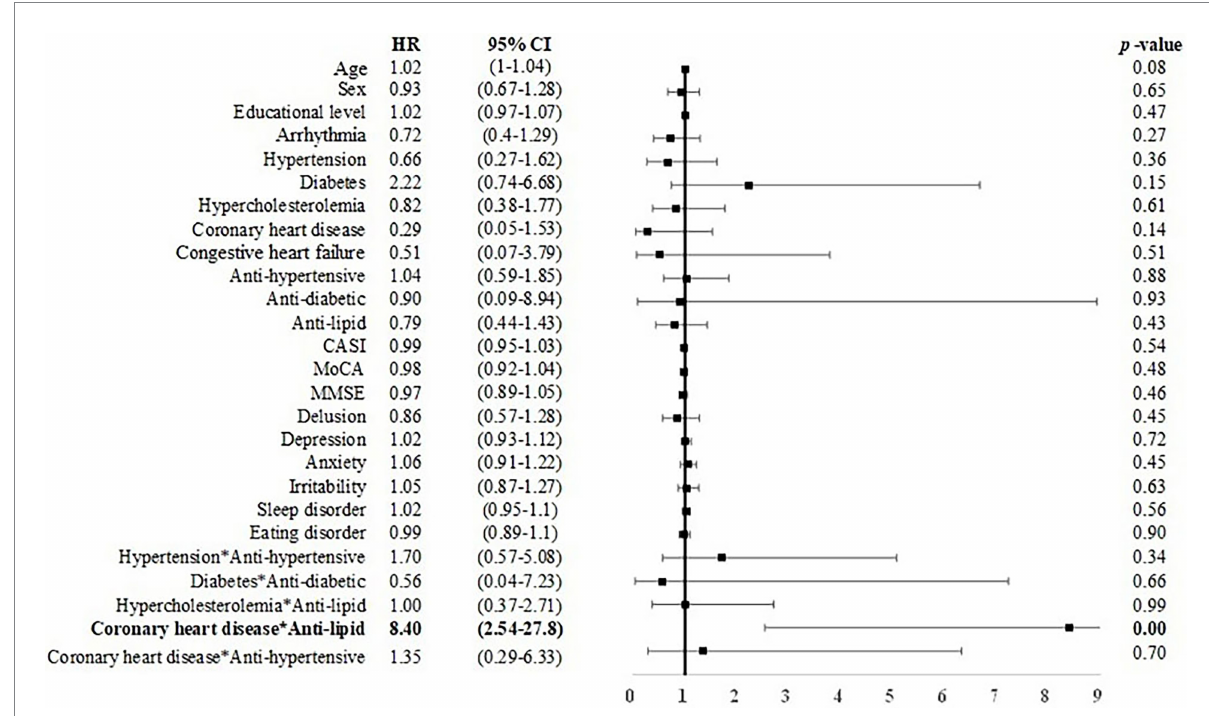
FIGURE 2 Risk of incident MCI among CU individuals. CASI, Cognitive Assessment Screening Instrument; MMSE, Mini-Mental State Examination, CI, confidence interval; HR, hazard ratio. Male sex was coded as 1 and female as 0 in the model. Bold font indicates statistically